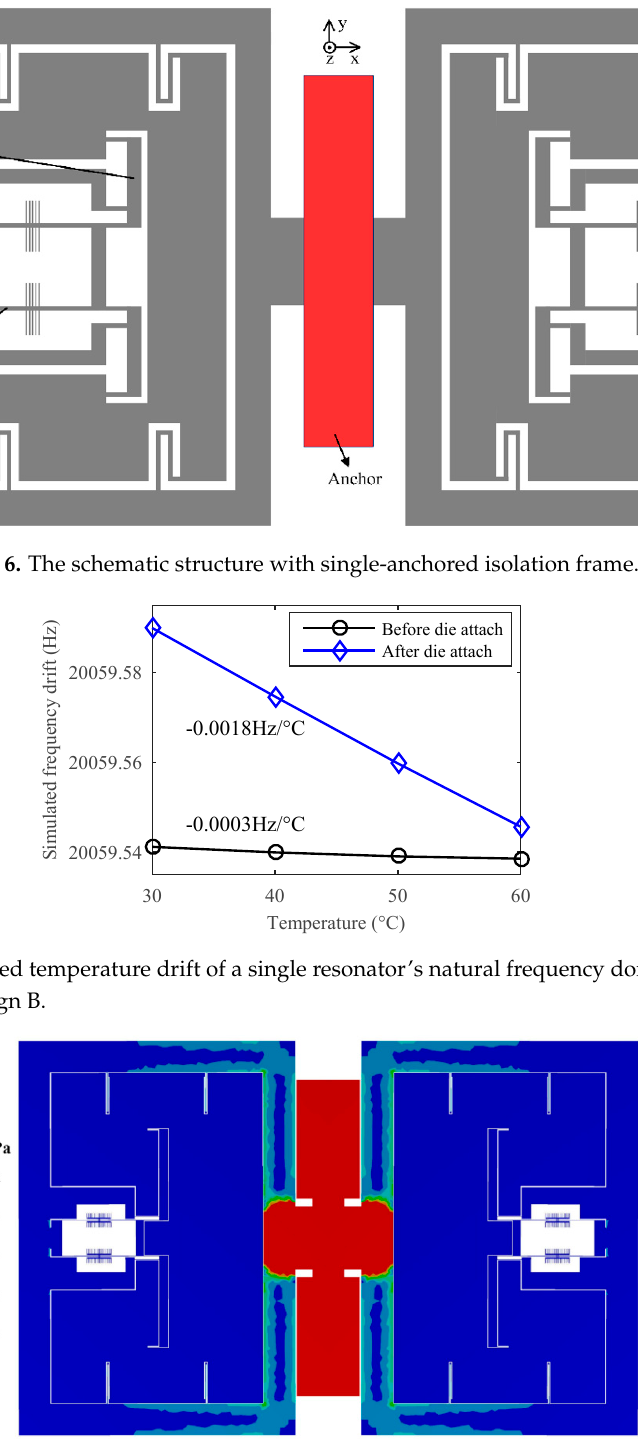
Figure 8. The simulated thermal stress distribution of the silicon structure after die attach in design B.